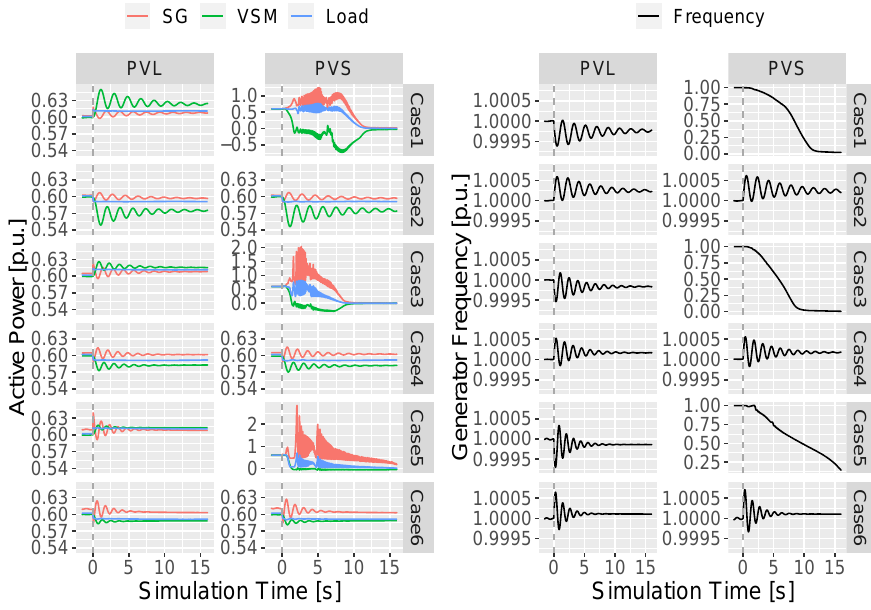
Figure 7. Active power flow of the grid and the frequency of the generator